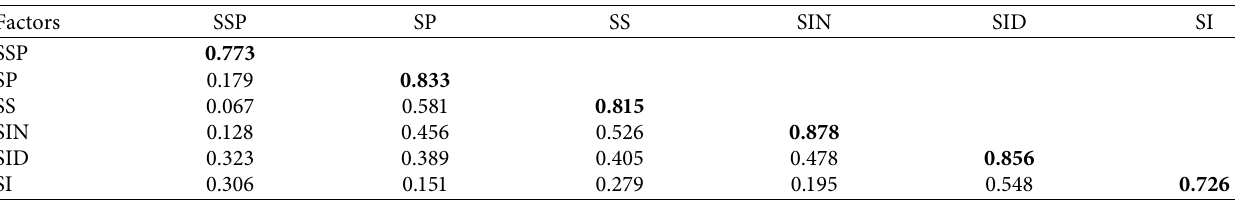
Table 4: Discriminant validity for the measurement model ( n � 258).